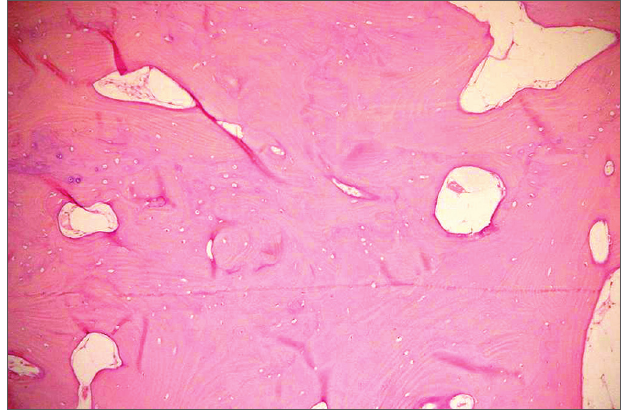
Figura 3. Pós-operatório de 2 anos: TC em vista coronal demostrando recidiva em ângulo mandibular